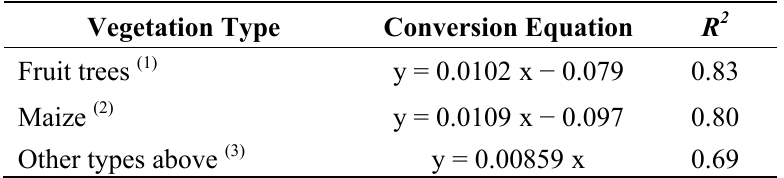
Table 1. Conversion equations used to convert relative SPAD-502 values to leaf chlorophyll concentration.